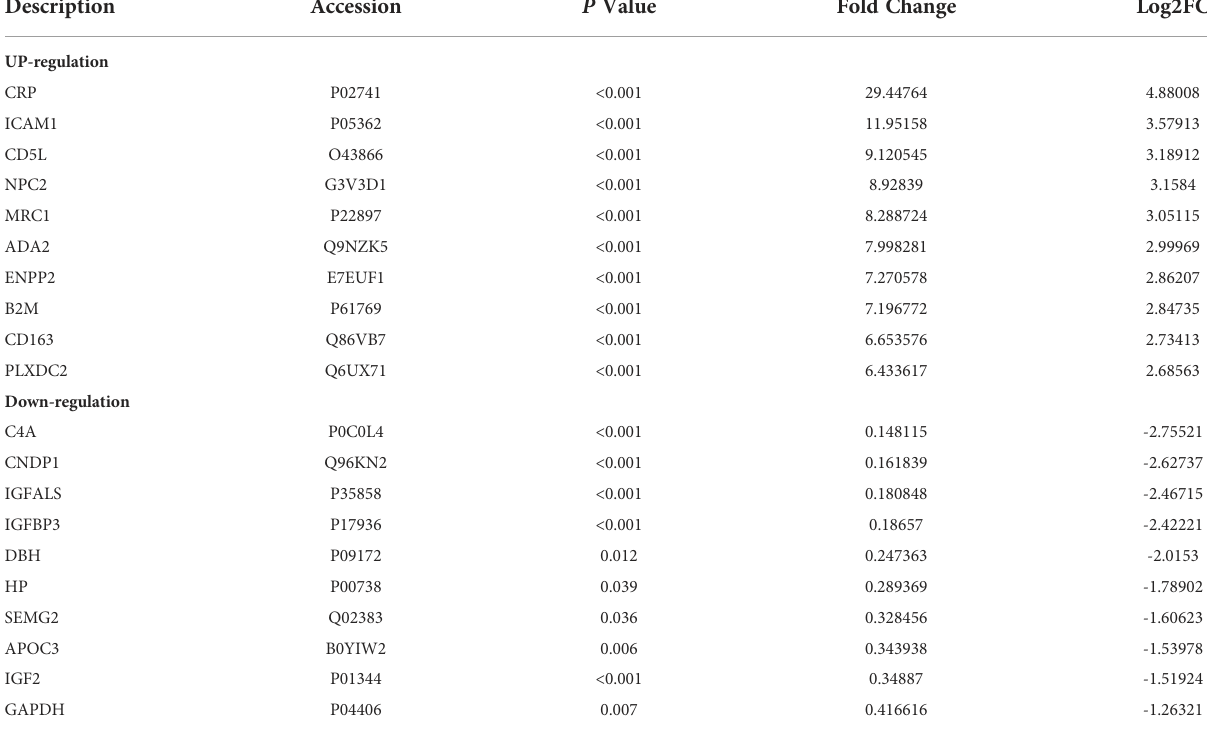
TABLE 4 Top 20 differentially expressed proteins.